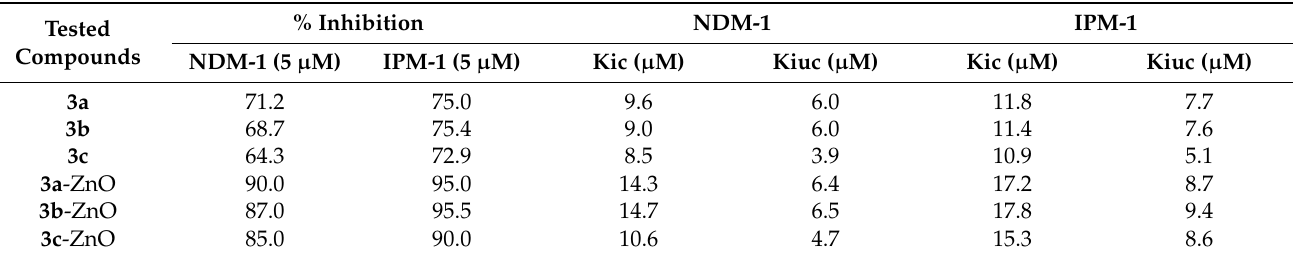
Table 4. Enzyme inhibition essay.